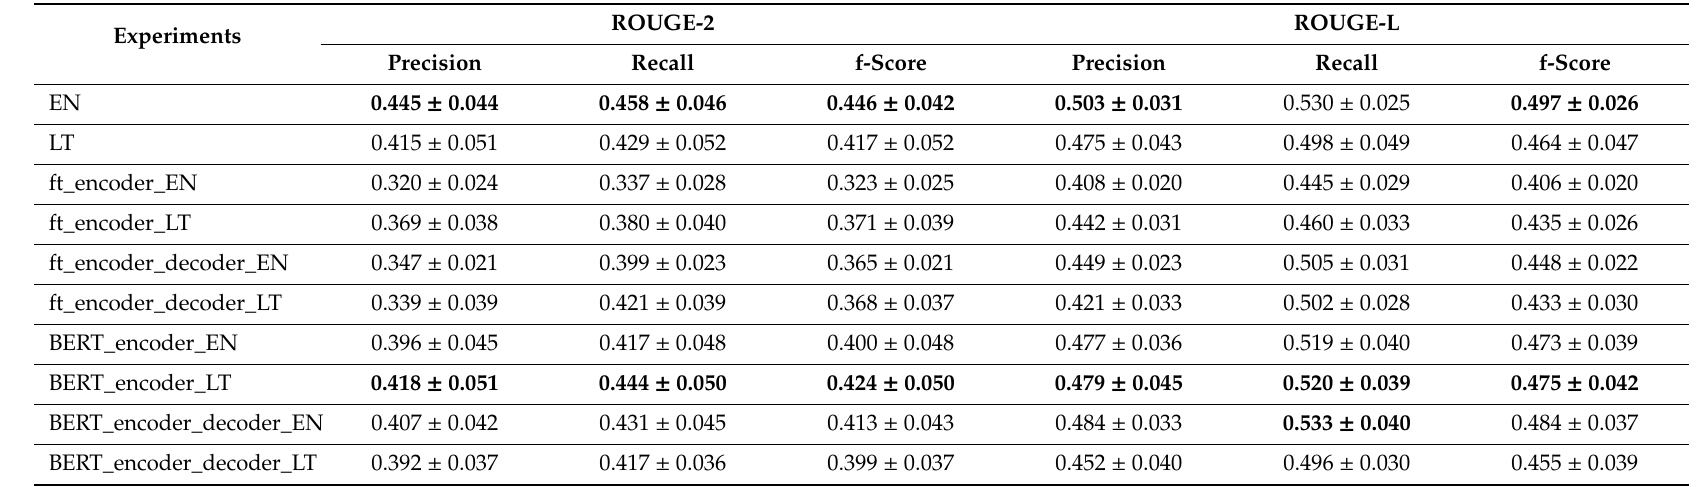
Table 5. Averaged ROUGE-2 and ROUGE-L precision / recall / f-score values with confidence intervals using the LSTM2 encoder and LSTM decoder model with di ff erent vectorization types on the dataset with separated punctuation. The best values in the column for EN and LT are in